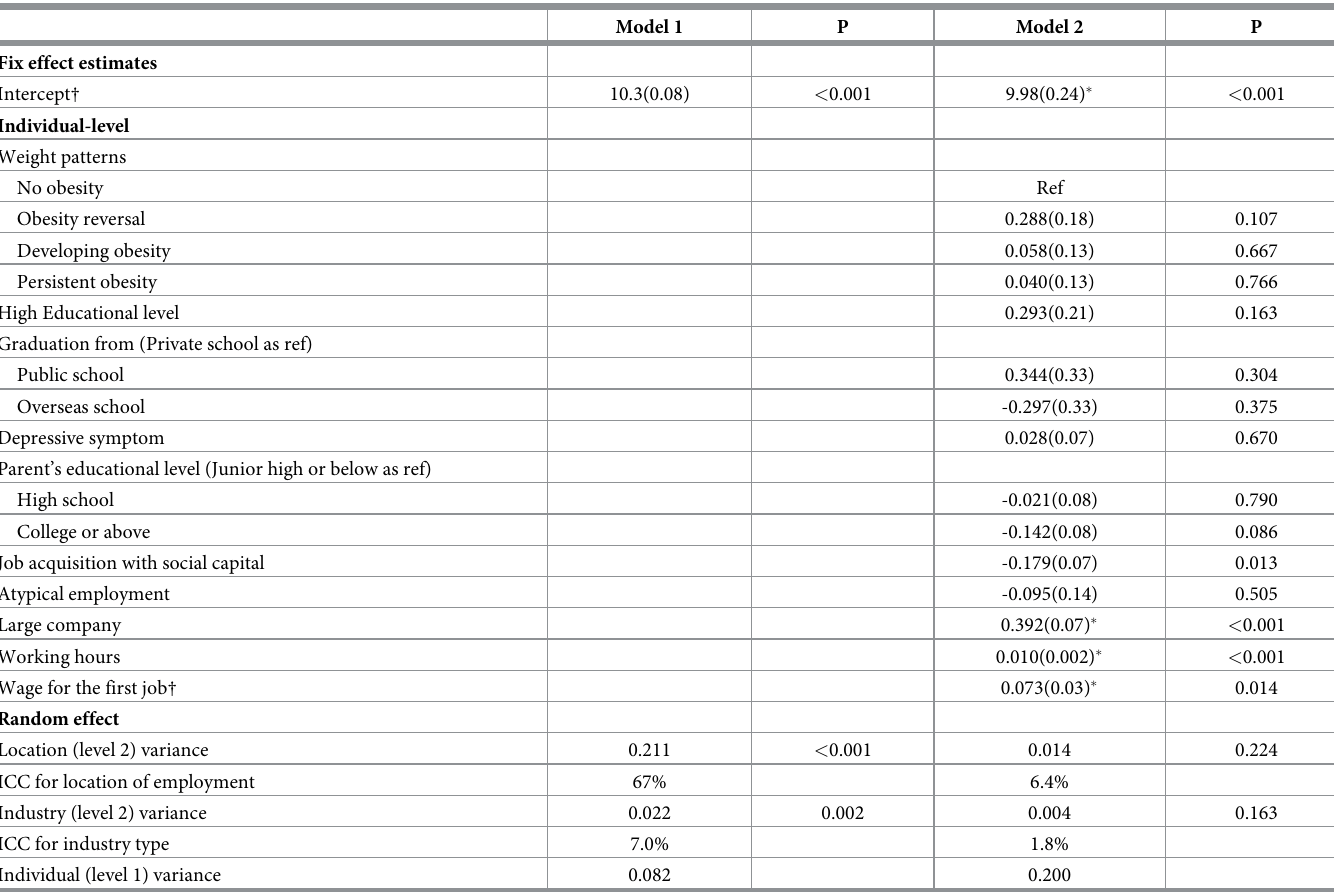
Table 2. Cross-classified multilevel model describing an association between predictors and monthly wage among men (N =